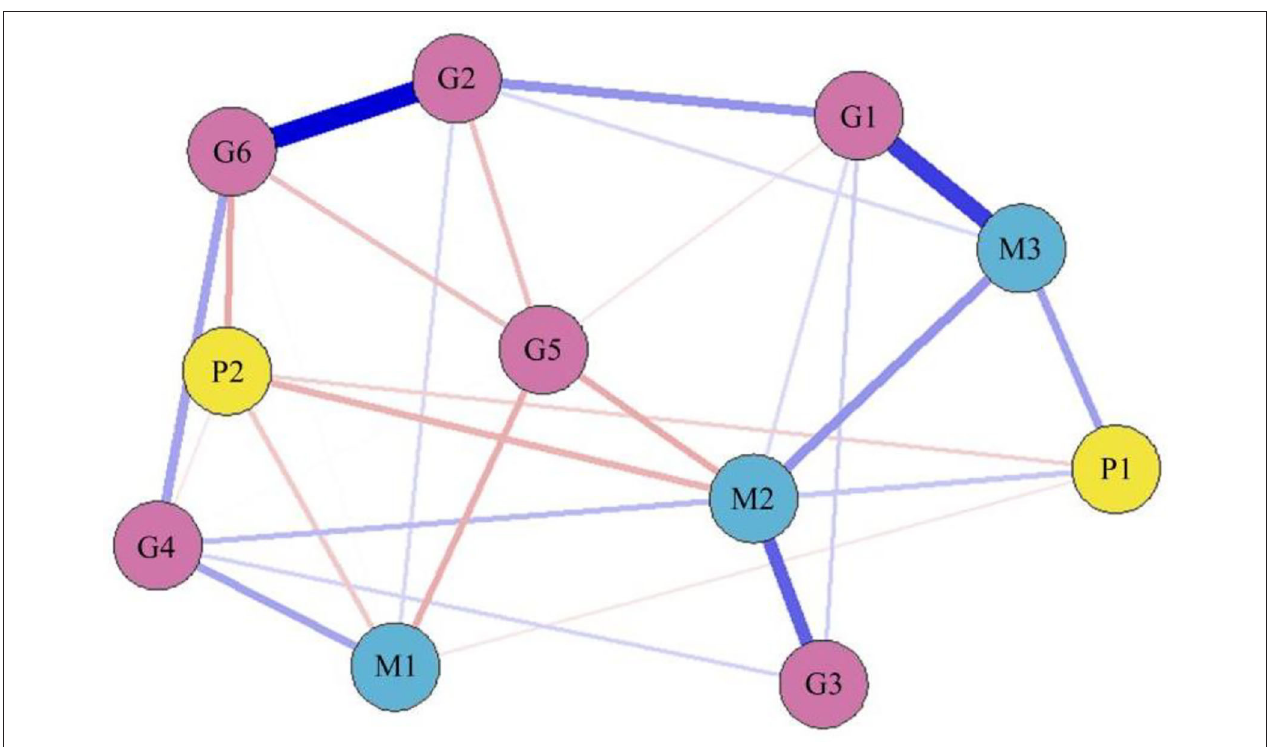
FIGURE 3 | The Weibo topic network. Blue line represents positive correlation and the red line represents negative correlation. The thicker the edge, the greater the correlation between two vertexes, and the thinner the edge, the smaller the correlation between two